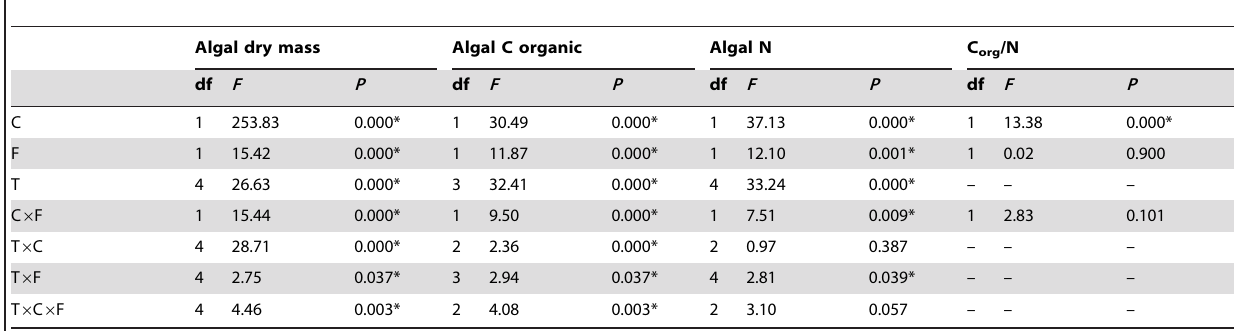
Table 2. Results of the 3-factorial ANOVA of the algal parameters.